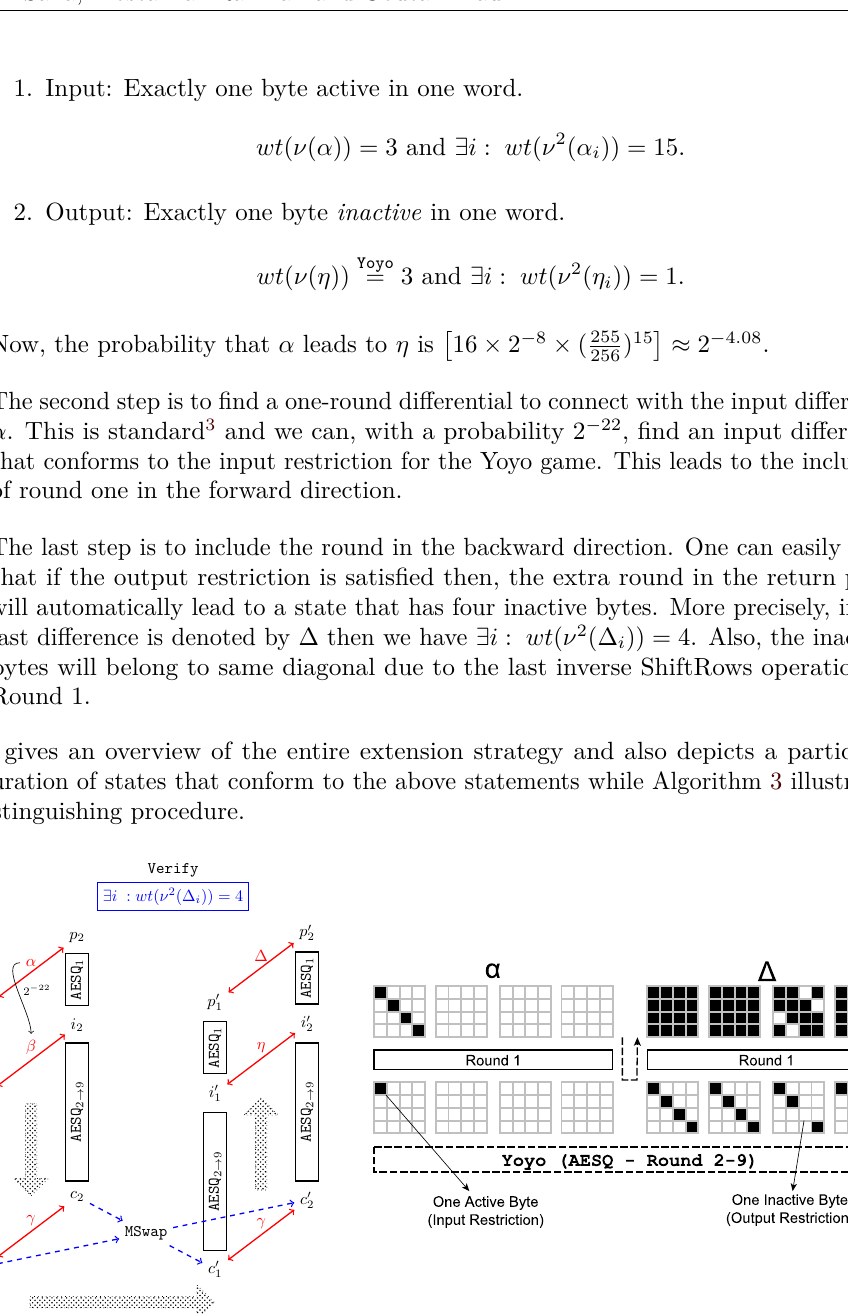
i h ∃ i : wt ( ν 2 (∆ i )) = 4 for AESQ and a corresponding 1 → 9 ) 60 ≈ 2 − 28 . 34 256